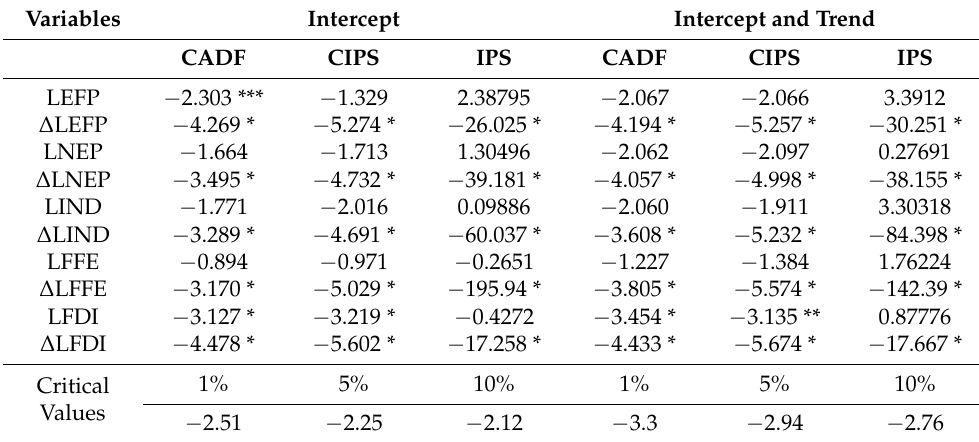
Table 5. Panel unit root results.